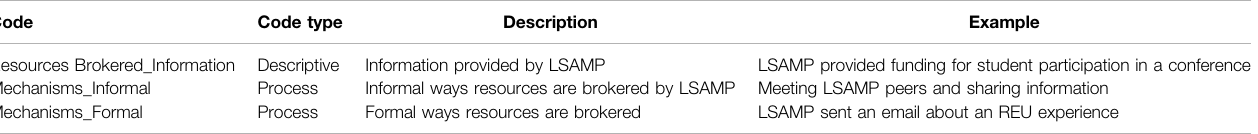
TABLE 5 | Sample coding